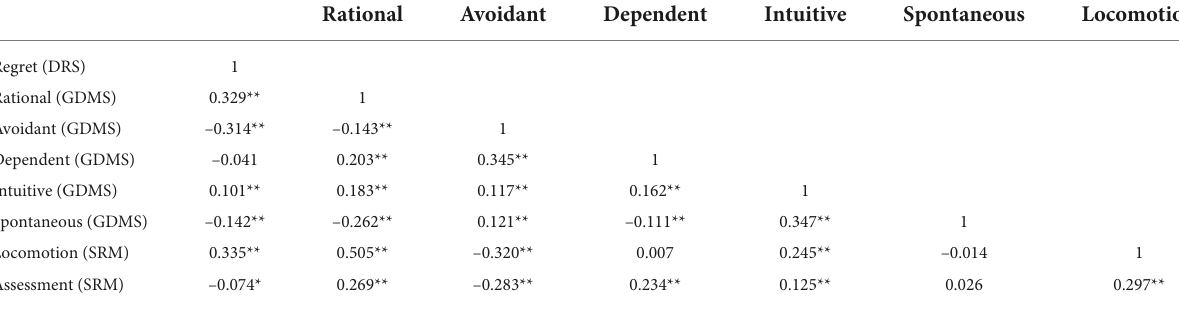
TABLE 6 Pearson’s